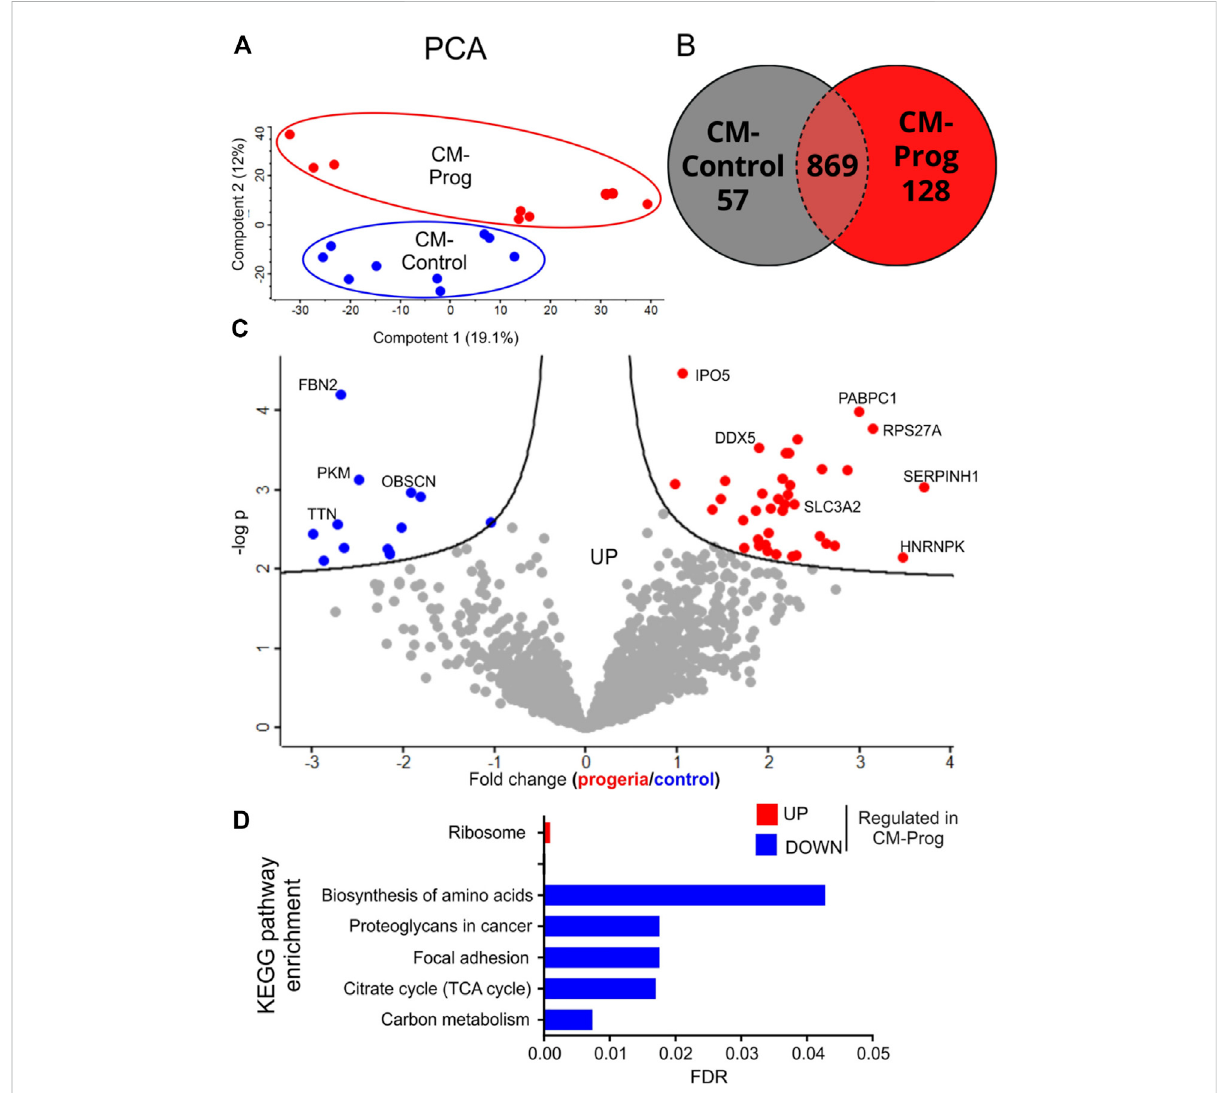
FIGURE 8 ProteomicanalysisofControlandHGPScardiomyocytes (A) PrincipalComponentAnalysis(PCA)ofthreedistinctdifferentiationsofiPS-derived cardiomyocytes from a Control and an HGPS patient run in triplicate. (B) Commonly and exclusively identi fi ed proteins in cardiomyocytes: a total of 1,054 proteins were identi fi ed; 869 proteins were expressed in both groups; 128 proteins were only expressed in Progeria and 57 proteins only in control. (C) Volcano plots showing differently expressed proteins: p values vs. the fold change in protein abundance between the two groups, whereproteinsabovethelinesinredareupregulatedinProgeriaandinbluearedownregulatedinProgeria)(FDR < 0.1). (D)